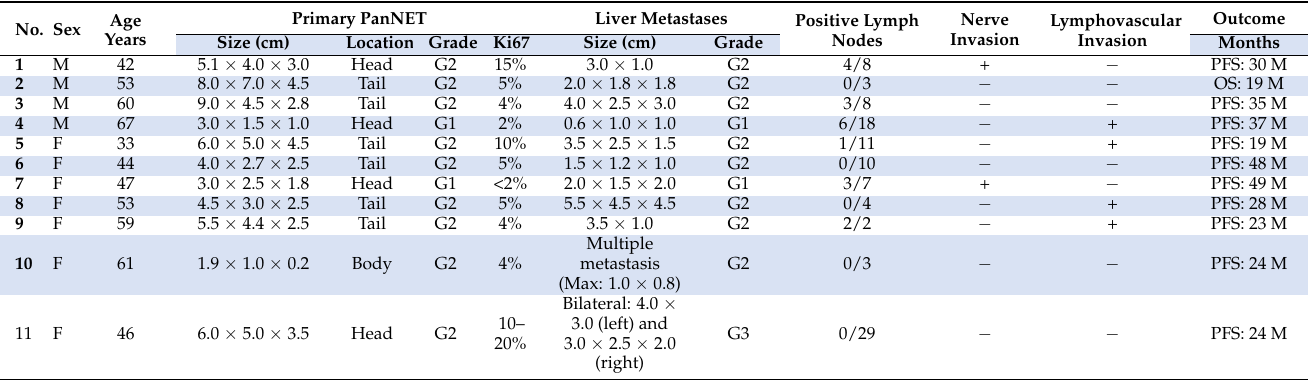
Table 1. Demographic and baseline characteristics of patients with pancreatic neuroendocrine tumors and liver